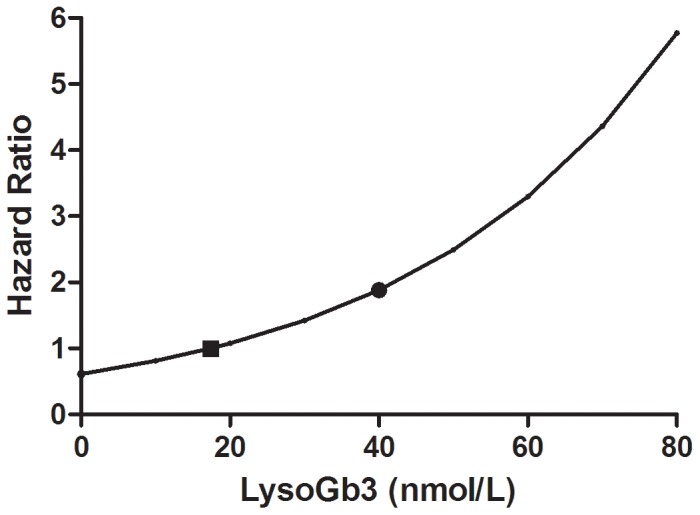
Risk to develop white matter lesions and LysoGb3.The hazard ratio to develop a (additional) white matter lesion or stroke decreases as the absolute value of lysoGb3 decreases. The dot represents mean lysoGb3 for males and females at start of ERT. The square depicts mean lysoGb3 level one year after start of ERT.